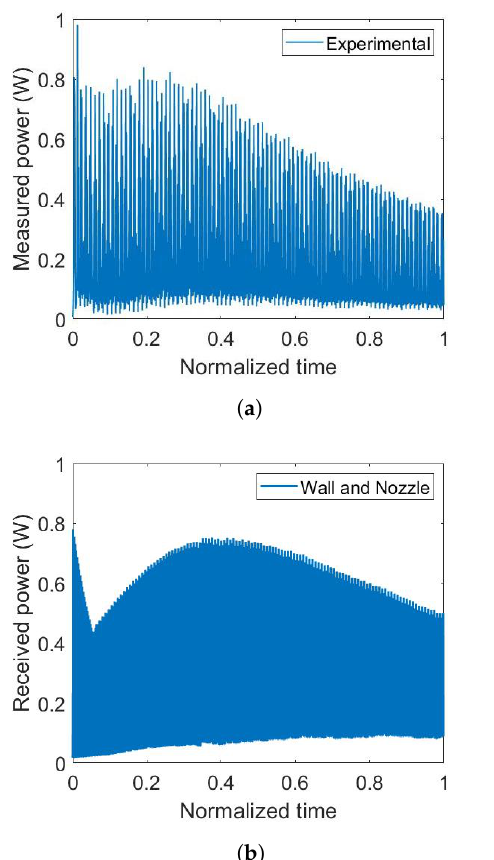
Figure 8. Radiative heat power on the sensor: ( a ) experimental results, ( b ) numerical